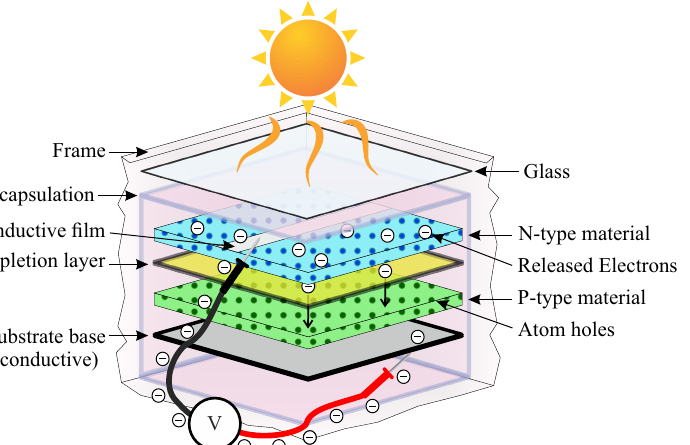
Figure 2. Illustration of a solar cell. A depletion layer separates two layers of semiconductor (doped) material (N and P, respectively). Base substrate and encapsulation layers are added at the bottom and top, respectively, and glass covers the cells/panel’s top. A metallic frame regularly covers the sides and bottom of a matrix of cells. The photons from solar light impact the N material, releasing electrons that flow through the voltmeter and fill the P material’s